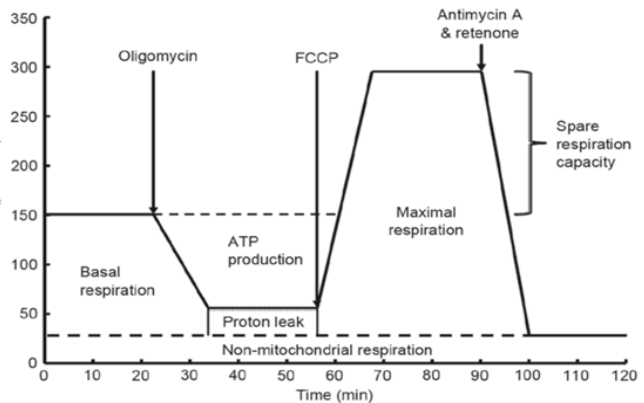
Figure 6. Evaluation of various types of mitochondrial respiration by oxygen uptake rate using the Seahorse Bioscience XF24 Seahorse Bioscience XF24 analyzer.